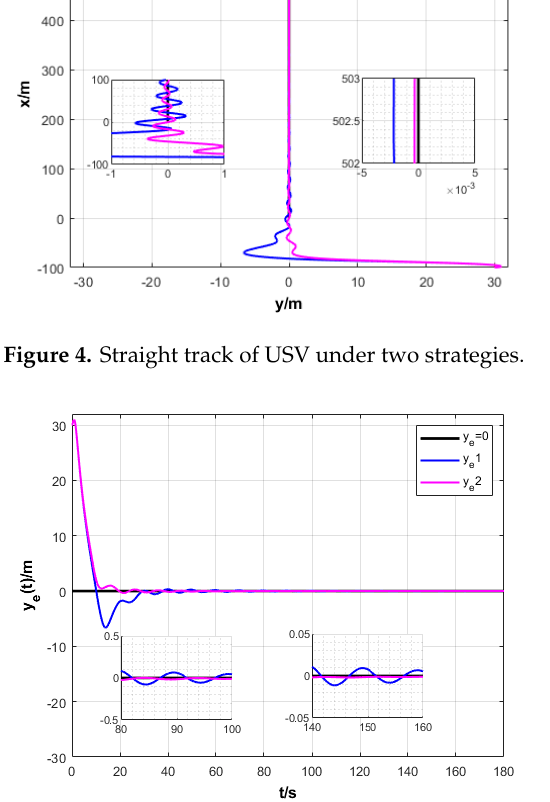
Figure 5. Transverse error of USV under two strategies.